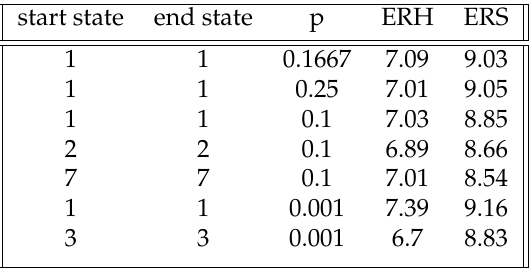
Table 3. A table to represent to display expected recurrence time under hexagonal and square tiling with different values of p